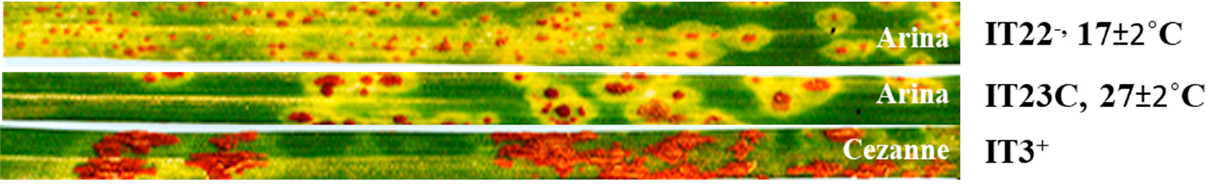
Figure 1. Infection types (ITs) produced by Arina ( Sr48 ) and Cezanne against pathotype Pgt 98- 1,2,3,5,6,7 at 17 ± 2 °C and 27 ± 2